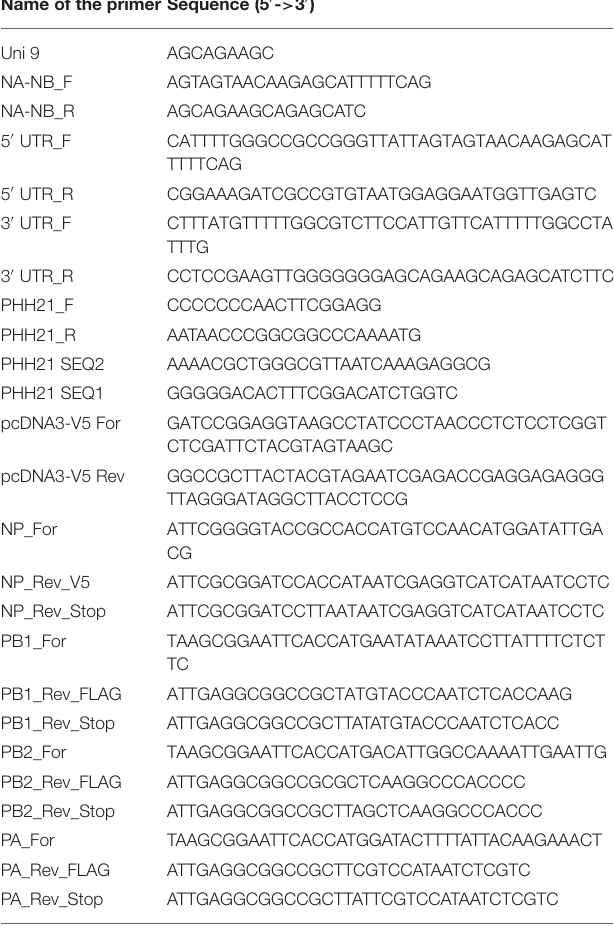
TABLE 1 | Primers used in this